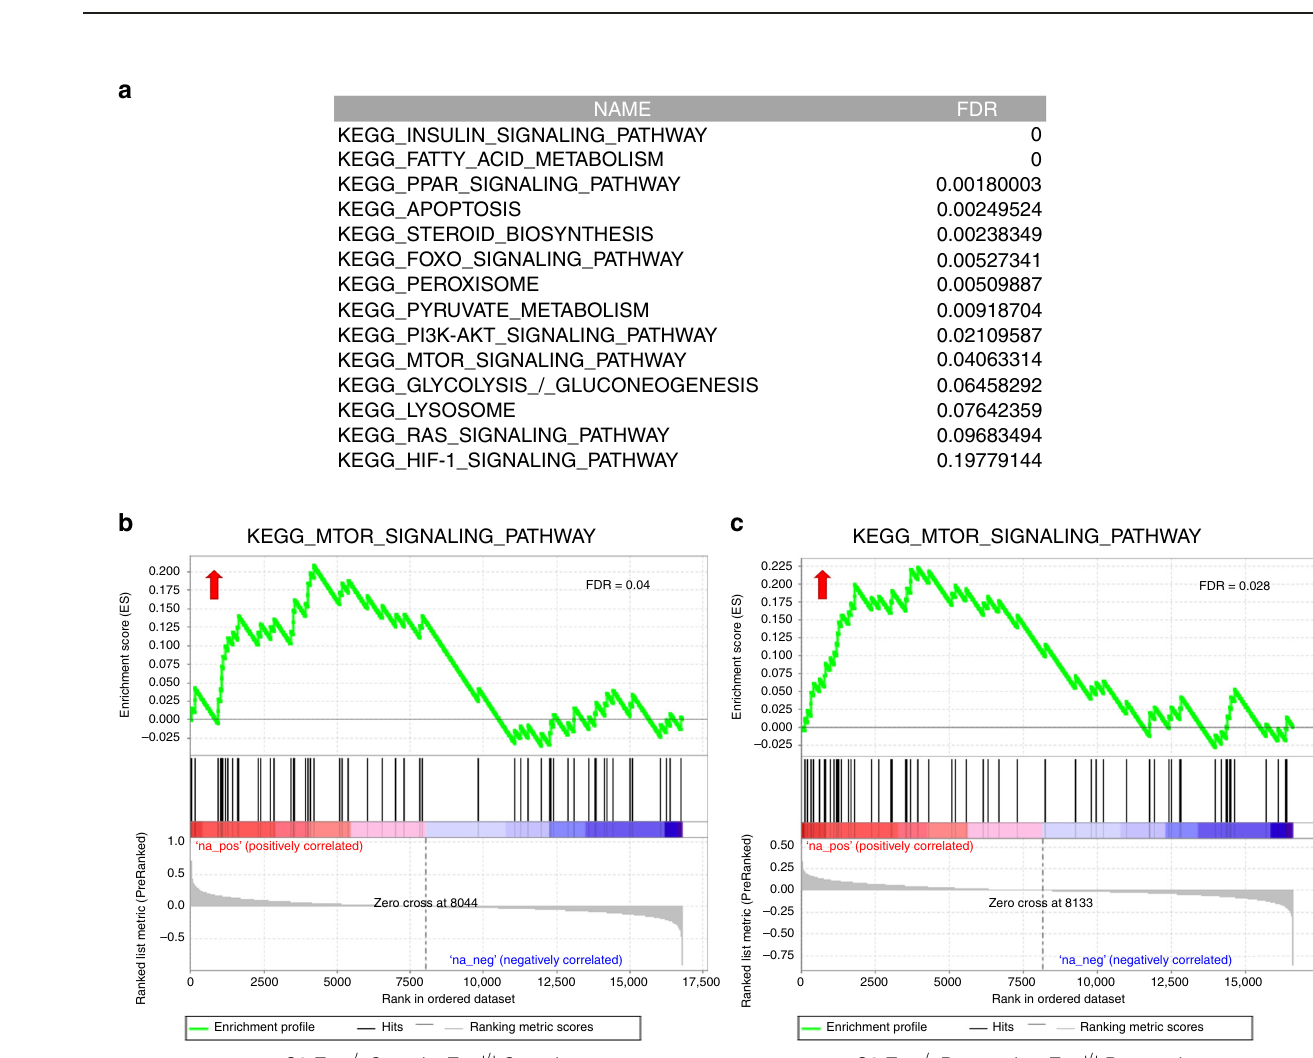
of pS6 in G2 Terc − / − mice (Fig. 3d, e; Supplementary Fig. 6). In addition, we found that other metabolic pathways related to the mTOR pathway 22 were also upregulated in G2 Terc − / − mice compared to wild-type mice, including insulin signaling,